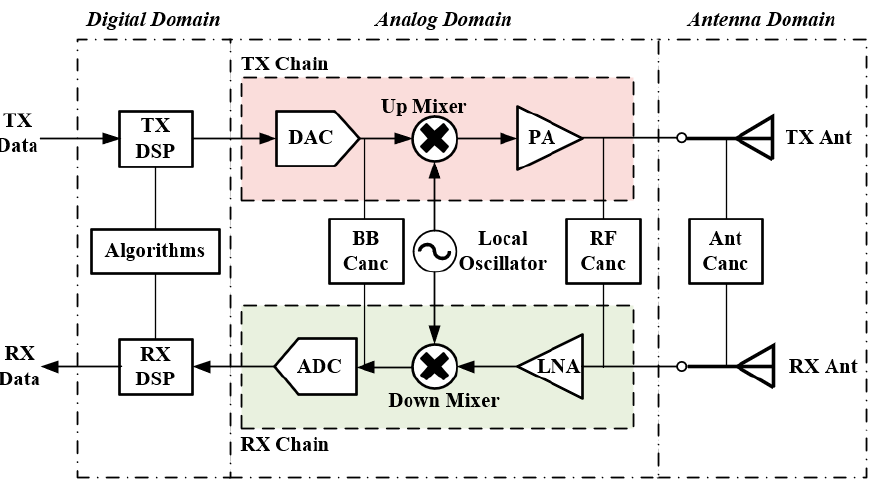
Figure 2. Typical in-band full-duplex (IBFD) system architecture with contents and boundaries of SIC in the digital, analog, and antenna/propagation (AP) domain.